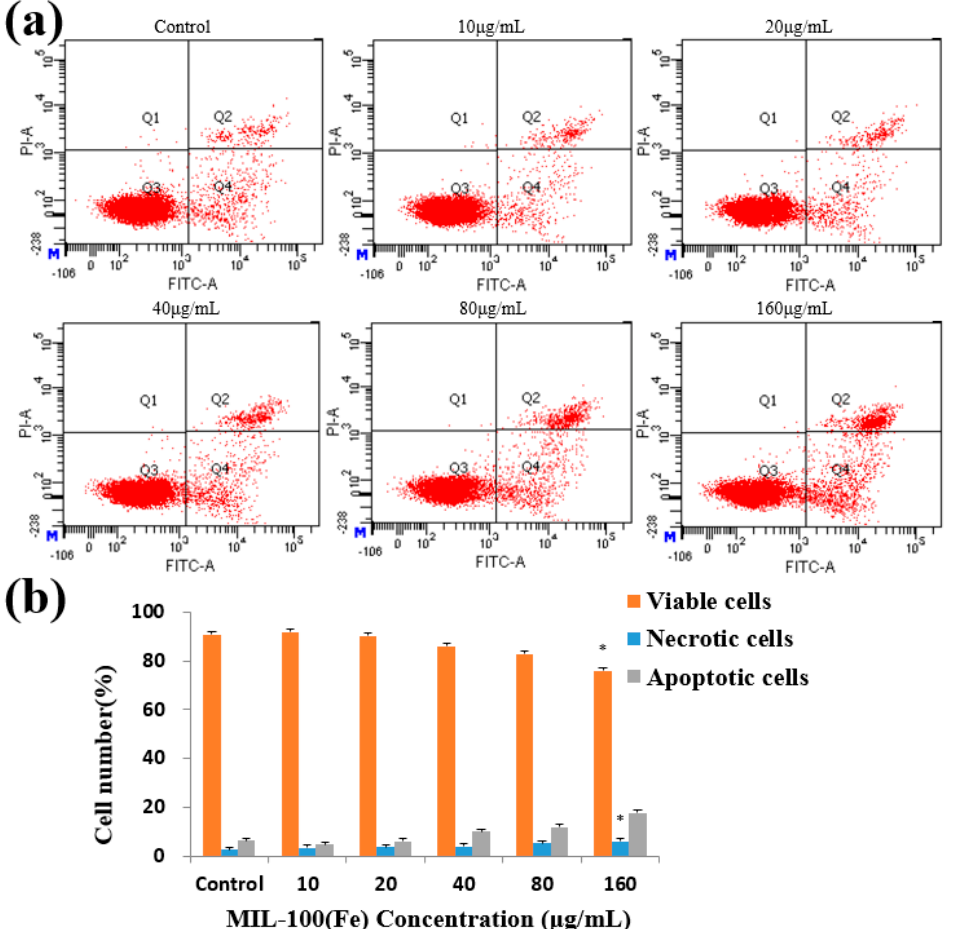
Figure 5. Effects of MIL-100(Fe) on apoptosis in HL-7702 cells. ( a ) Flow cytometry detection of apoptosis with FITC-annexin V/PI double staining. ( b ) The percentages of viable, necrotic, and apoptotic HL-7702 cells after incubation with different concentrations of MIL-100(Fe) for 48 h. The data are expressed as means ± S.D. from three independent experiments. (* p < 0.05 vs. Control.)